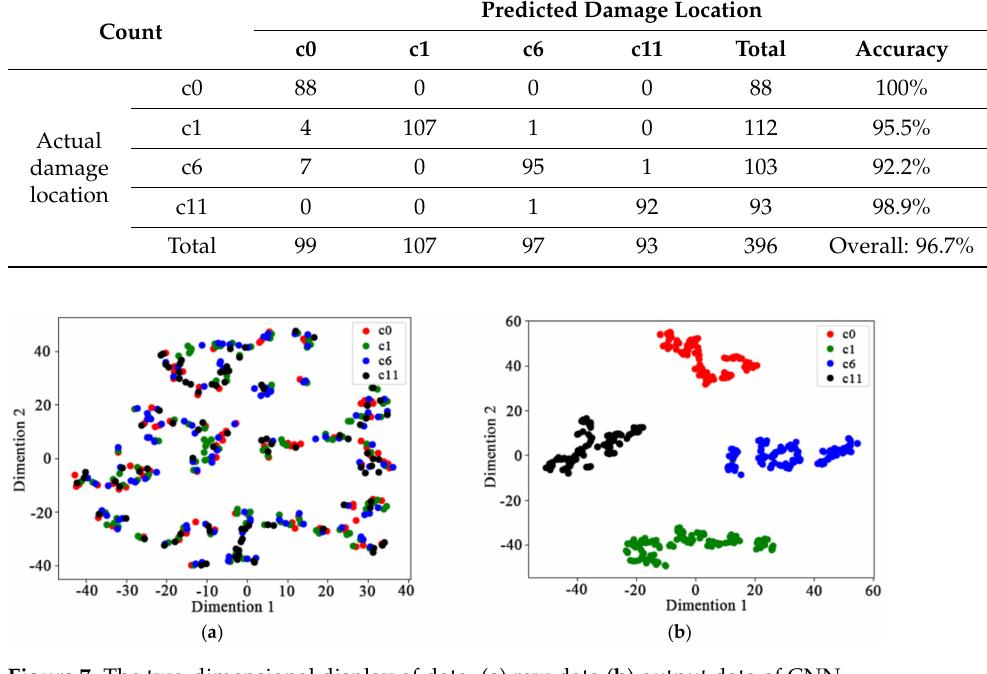
Figure 7. The two-dimensional display of data. ( a ) raw data ( b ) output data of